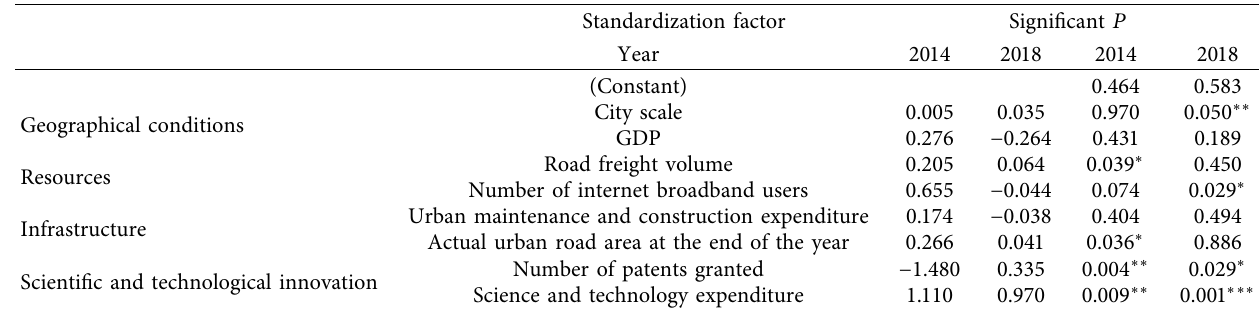
Table 4: Regression analysis of factors influencing the freight network of urban agglomeration in the middle reaches of the Yangtze